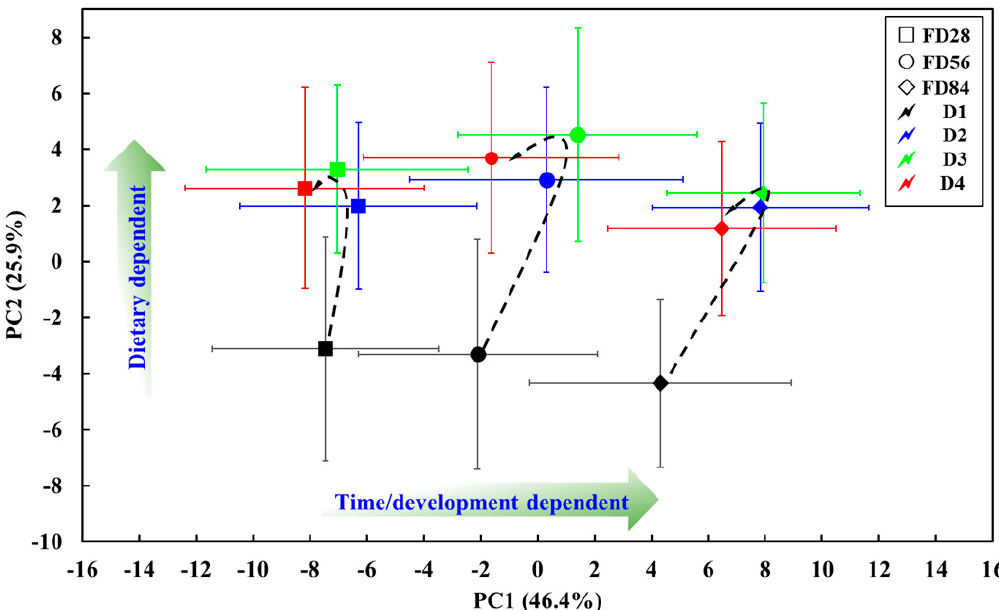
Figure 3. PCA score plots of the intestine of grouper fed four di ff erent diets of D1: 0.0% (black), D2: 0.5% (blue), D3: 1.0% (green), and D4: 1.5% (red) at FD28 ( (cid:3) ), FD56 ( ) and FD84 ( ♦ ). The point with error bars represents the mean and standard deviation of the mean for each diet at di ff erent sampling time point, respectively. The hand-drawn trajectories display the path of the metabolic profiles in response to taurine supplementation.